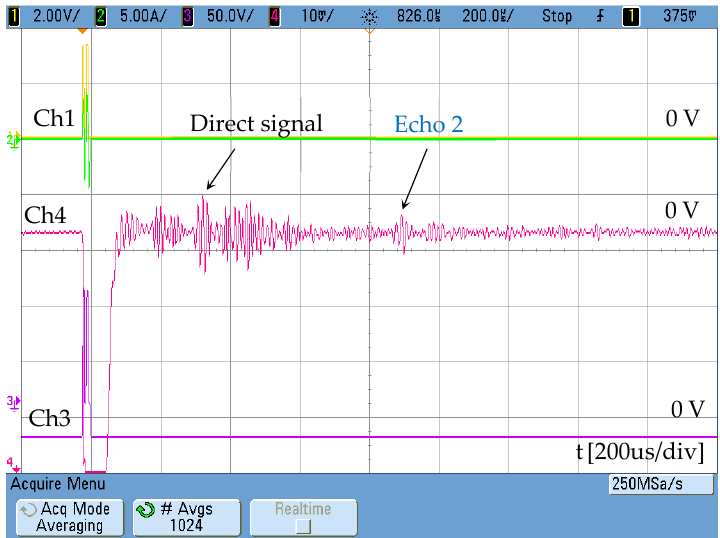
Figure 18. Magnetostrictive transducer response with DC magnetic bias (two NdFeB magnets) Ch4: [10 mV/div]. Ch1 shows the activation signal of the power stage [2 V/div] and Ch3 the voltage at resonant circuit [50 V/div]. The maximum AC current is 5A.